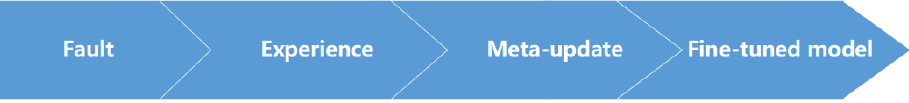
Figure 2. Flowchart of the FTC